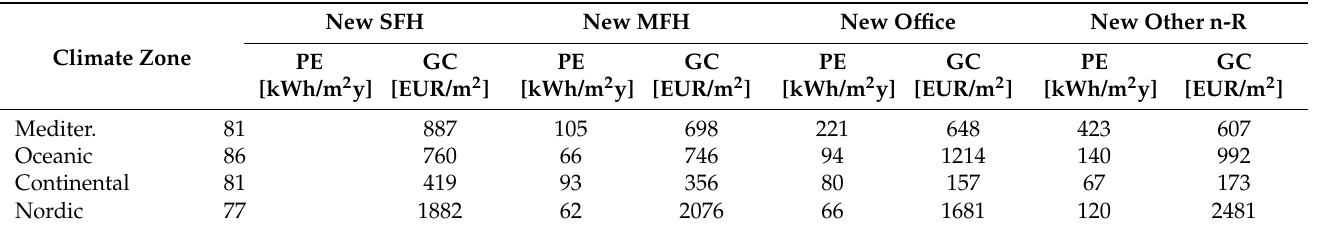
Table 4. Average cost-optimal levels (PE: Primary Energy and GC: Global Cost) for new buildings per climatic condition.